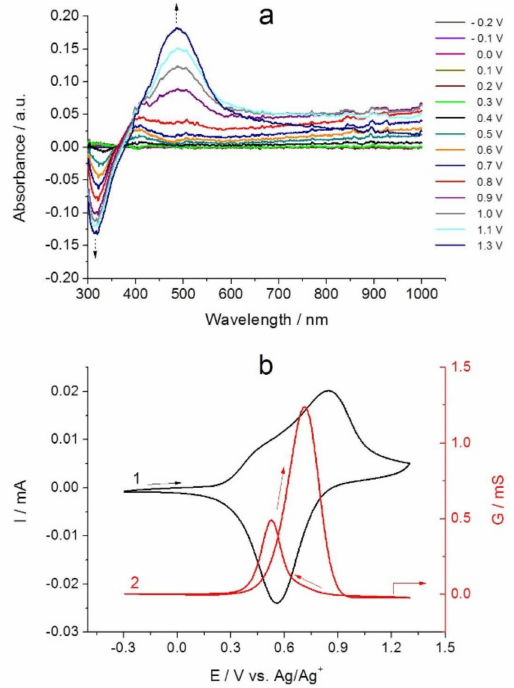
Figure 12. ( a ) Differential UV-Vis spectra of a poly-[NiSalen]-modified ITO-coated glass electrode in 0.05 M Et 4 NBF 4 /DCE in the potential range from − 0.9 to 1.3 V, referenced to the spectrum of the polymer at − 0.9 V; ( b ) cyclic voltammogram (black curve 1) and conductance profile (red curve 2) of a poly-[NiSalen]-coated interdigitated electrode in 0.05 M Et 4 NBF 4 /DCE at a scan rate of 0.01 V s − 1